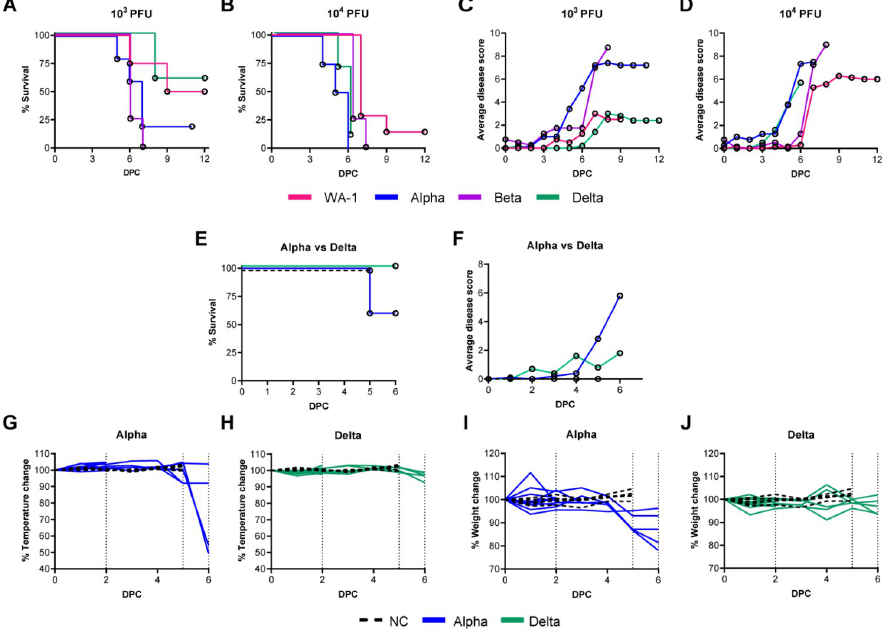
Fig 1. Survival, disease scores, weight, and temperature of K19-hACE2-mice challenged with WA-1, Alpha, Beta, and Delta strains. K18-hACE2 transgenic mice were intranasally challenged with 10 3 or 10 4 PFU WA-1, Alpha (B.1.1.7), Beta (B.1.351) or Delta (B.1.617) SARS-CoV-2, or mock-challenged with PBS (NC). Post-challenge, mouse survival (A, B) (n = 4 for 10 3 WA-1, n = 7 for 10 4 WA-1, n = 3 for 10 3 Alpha, n = 4 for 10 4 Alpha, n = 4 for 10 3 Beta, n = 4 for 10 4 Beta, n = 5 for 10 3 Delta and n = 10 for 10 4 Delta) and average disease scores per group on each day (C, D) were evaluated. Based on experimental results, mice challenged with Alpha (n = 10 split between timepoints) and Delta (n = 10 split between timepoints) or mock-challenged with PBS (n = 5), were evaluated at day 2 and day 6 post- challenge to measure survival (E), average disease scores (F), changes in rectal temperature (G, H) and bodyweight(I, J). Dotted lines indicate euthanasia points on day 2, day 5 (euthanasia of mock-challenge controls) and day 6. NC = no challenge.